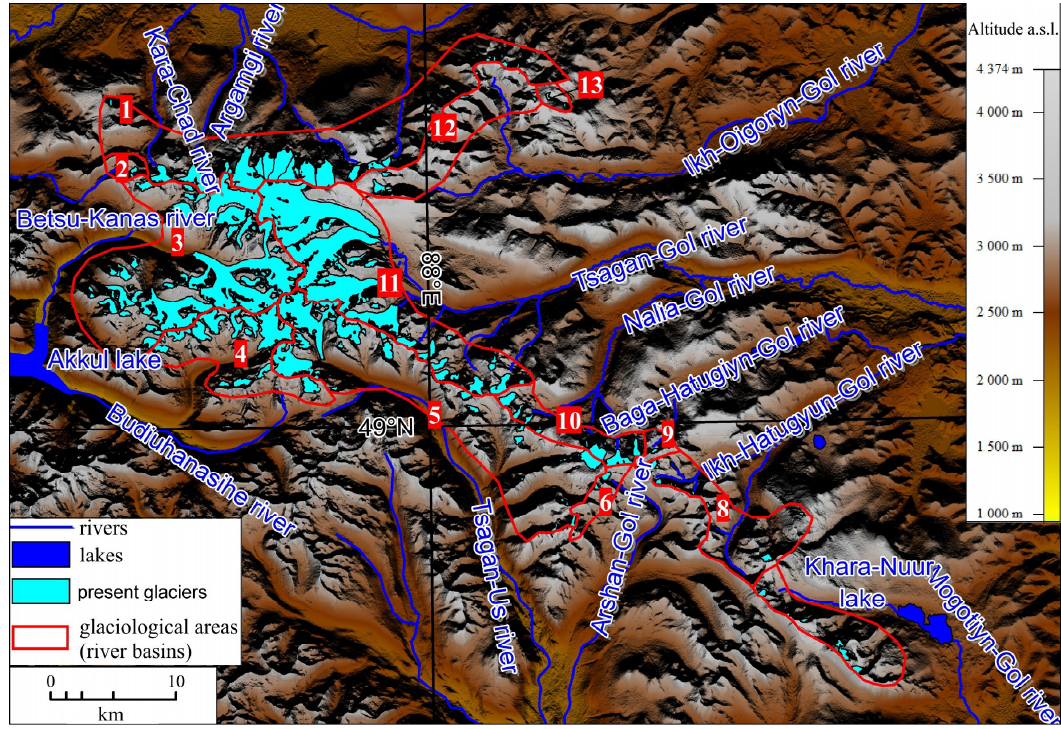
Figure 3. Glacial areas (river basins) of Tavan Bogd. 1—Kalguty, 2—Ak‑Alaha, 3—Sangadyr, 4—